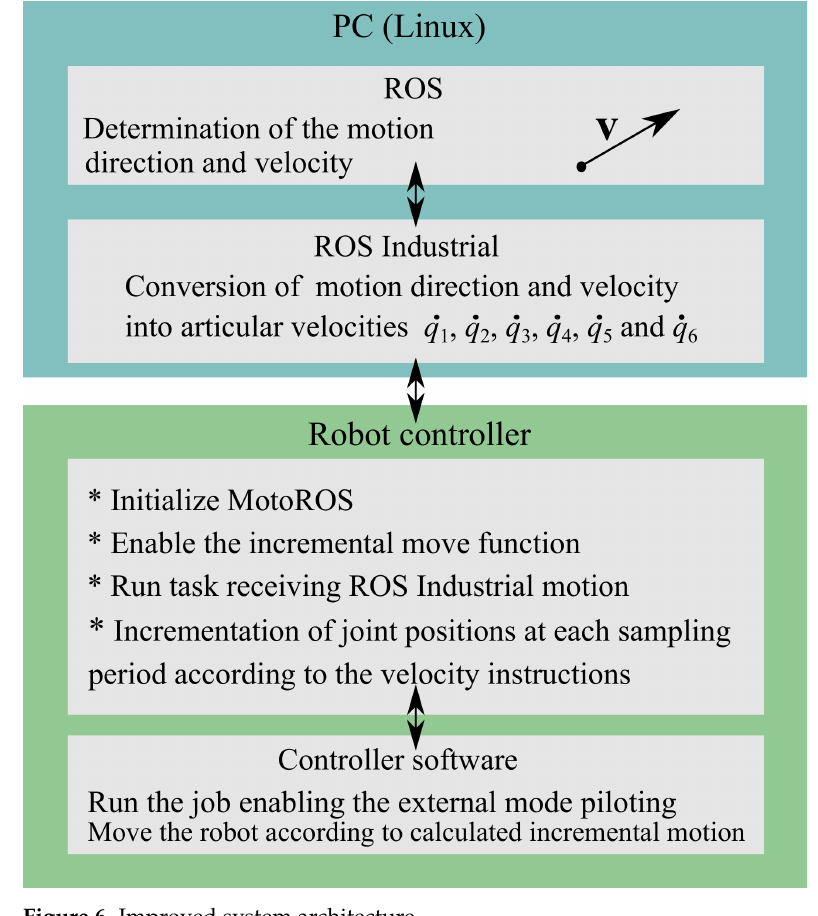
Figure 6. Improved system